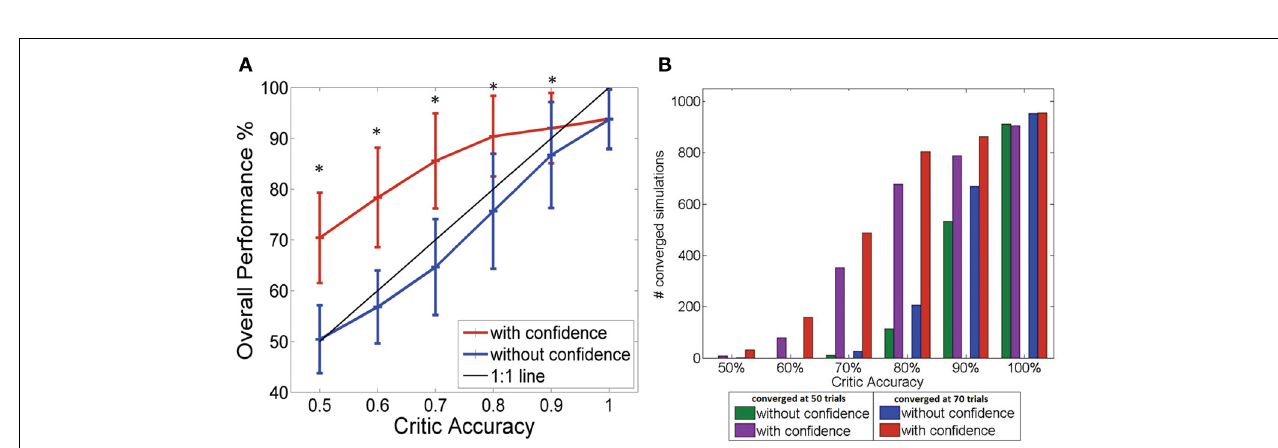
0.001). The overall performance of the blue curve is limited by the accuracy of the critic but the overall performance of the red curve is able to go